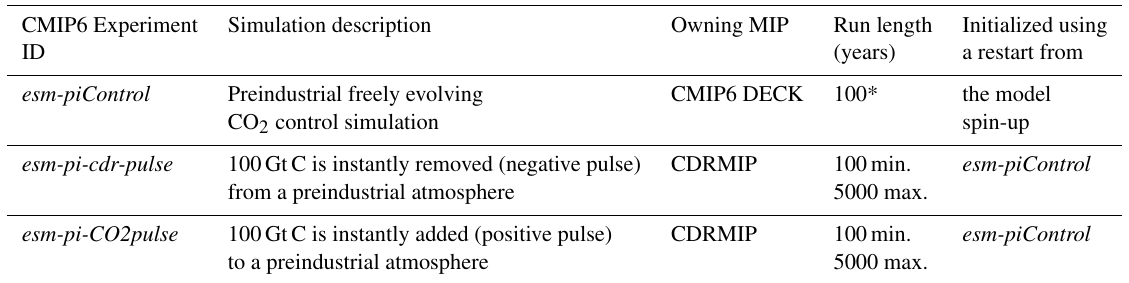
Table 3. Instantaneous CO 2 removal from an unperturbed climate experiment ( CDR-pi-pulse ) simulation. All simulations are required to complete the experiment.